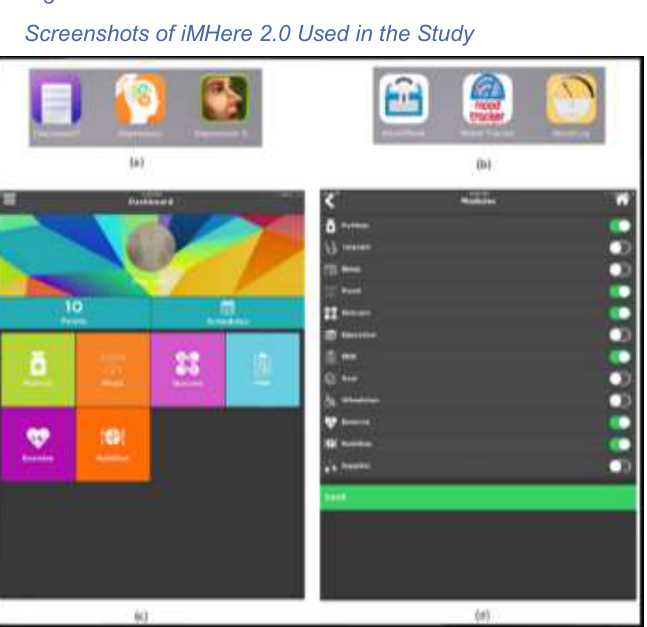
Note . (a) Icons of apps used for M1 demonstration. (b) Icons of apps used for M2 demonstration. (c) A screenshot of iMHere 2.0 dashboard. Six modules (MyMeds, Mood, Skinacre, PHR, Exercise, and Nutrition) are shown. (d) A screenshot of the in-app module selection page in settings of iMHere 2.0. Users can turn on or off each individual module on this